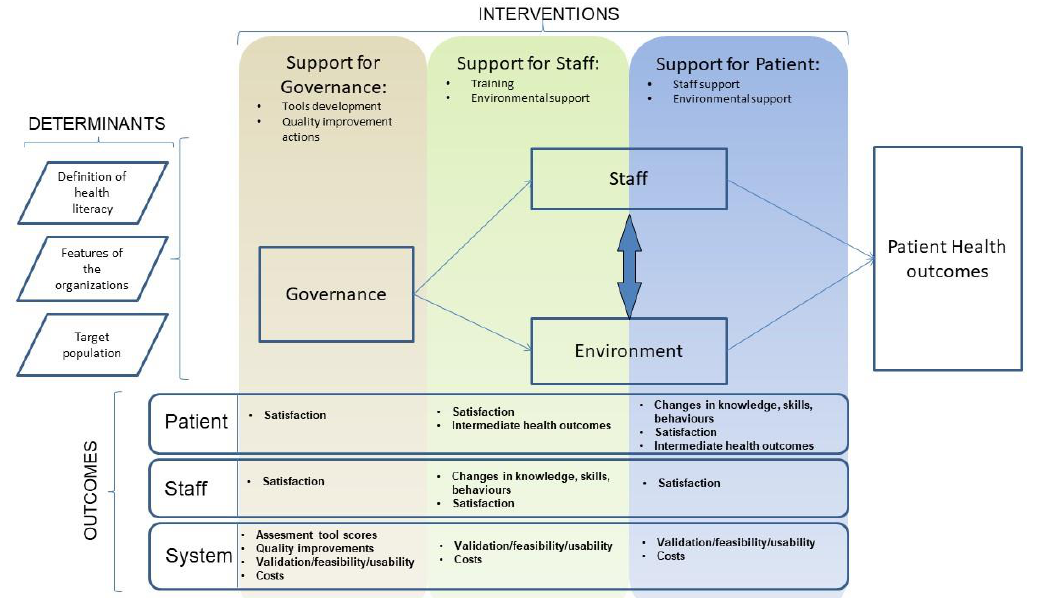
Figure 2. Logical Figure 2. Logical framework.